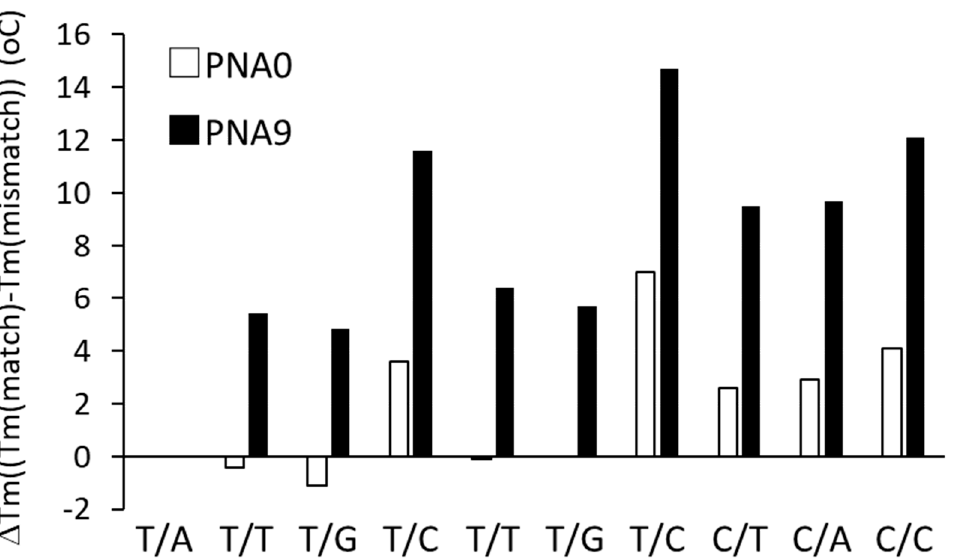
Figure 8. Measurement of Tm for PNA 0 / DNAs and PNA 9 / DNAs in 20 mM phosphate bu ff er (pH 7.4). ∆ Tm = Tm (matched) − Tm (mismatched). DNA 1 contains a complementary sequence to the PNAs. DNA 3 , DNA 4 , and DNA 5 contain a mismatched base at the first, second, and third base from the N-terminus of the PNA.